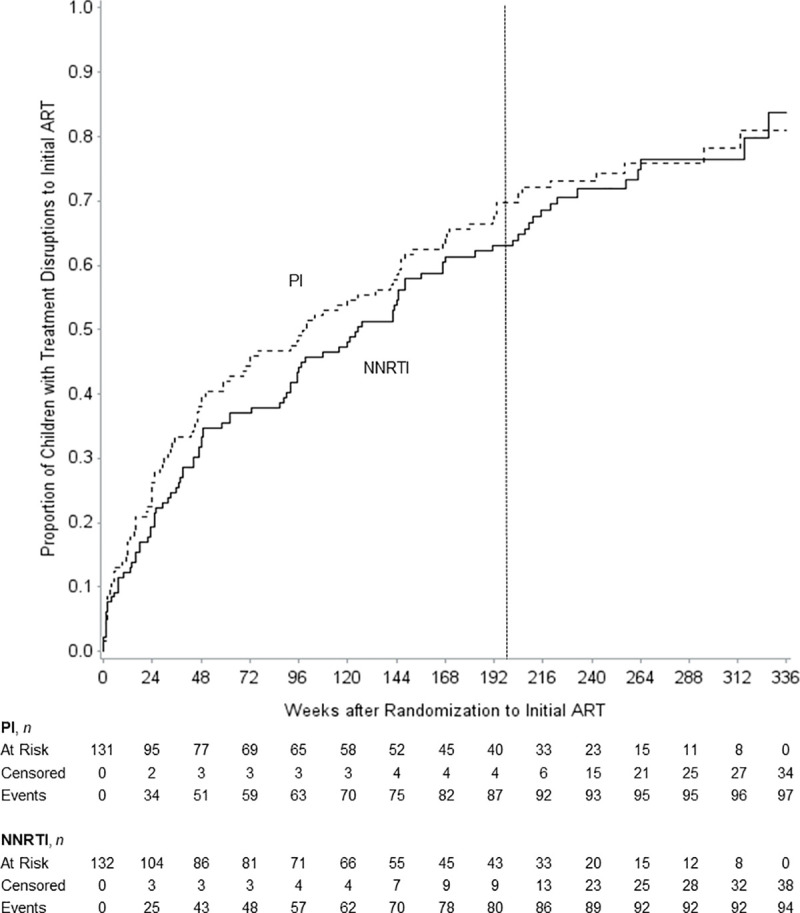
Proportion of children experiencing treatment disruption from initial ART regimen by study week.The vertical line delineates 4 years on study. ART, antiretroviral therapy; n, subsample size; NNRTI, non-nucleoside reverse transcriptase inhibitor; PI, protease inhibitor.